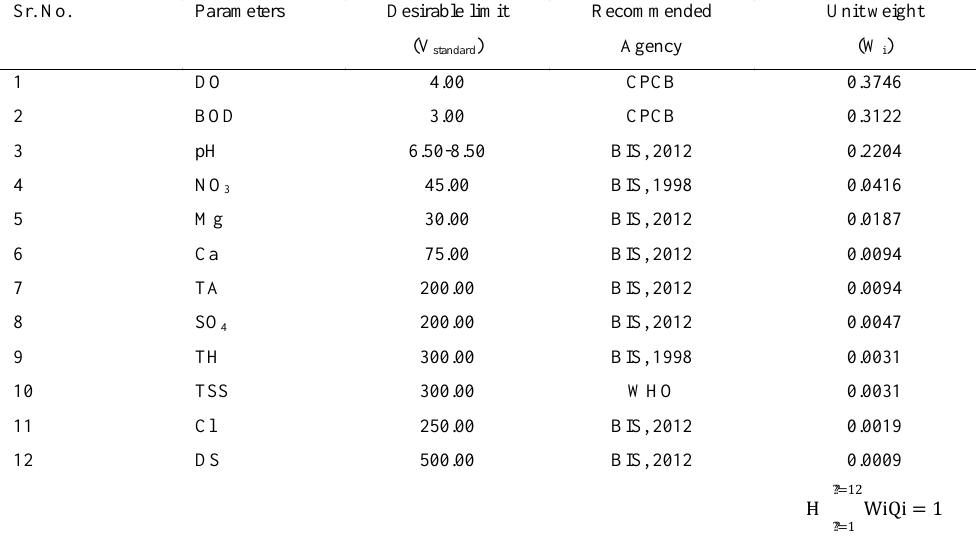
Table 6: Sample Calculation of WQI at